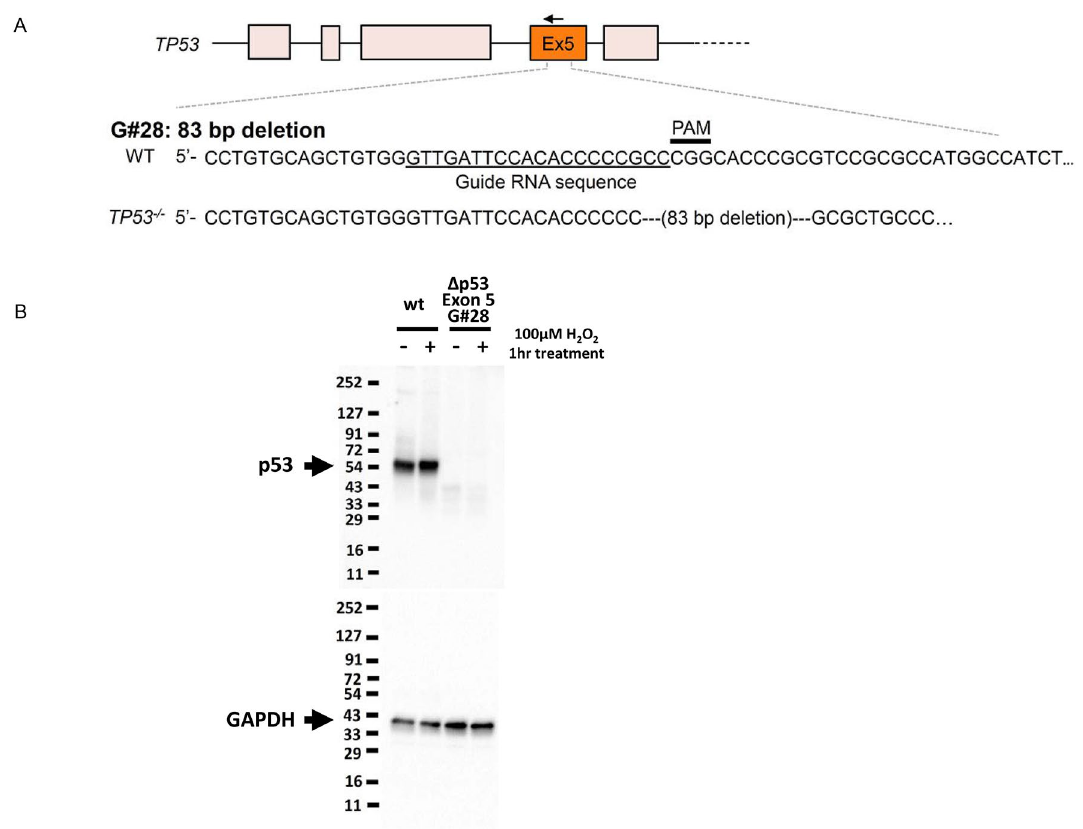
Figure 2. Knockout of p53 with the CRISPR/Cas9 system. (A) Induction of 83 bp deletion in exon 5 of p53 using the CRISPR/Cas9 system. (B) Confirmation of suppression of p53 expression in G#28 with western blotting. Induction of apoptosis by H 2 O 2 enhanced TP53 expression in wt (BiPSC13), but TP53 expression was not observed in G#28 regardless of H 2 O 2